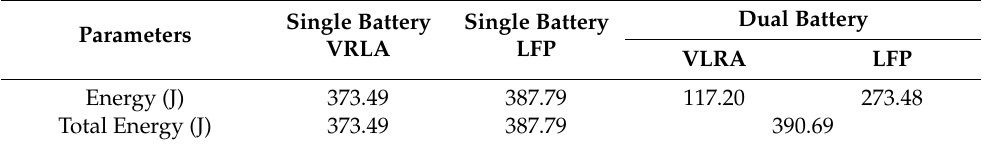
Table 3. Energy consumption of battery.